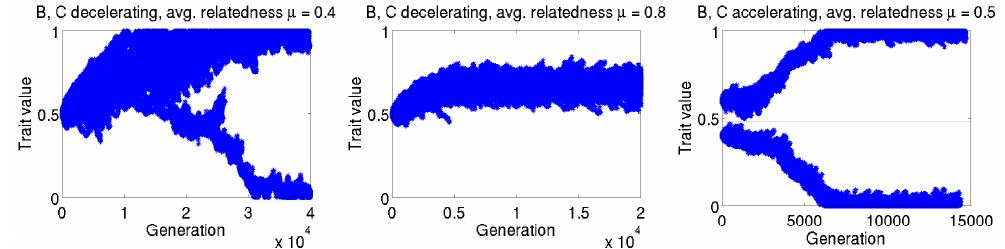
Figure 4. Simulations using group size N = 10, and B and C both decelerating or both accelerating. As predicted by the analytical investigation, when B and C are decelerating, the population undergoes evolutionary branching when µ = 0.4, and it reaches evolutionary stability when µ = 0.8. When B and C are accelerating, bistability occurs when µ = 0.5. In all three cases, σ 2 =